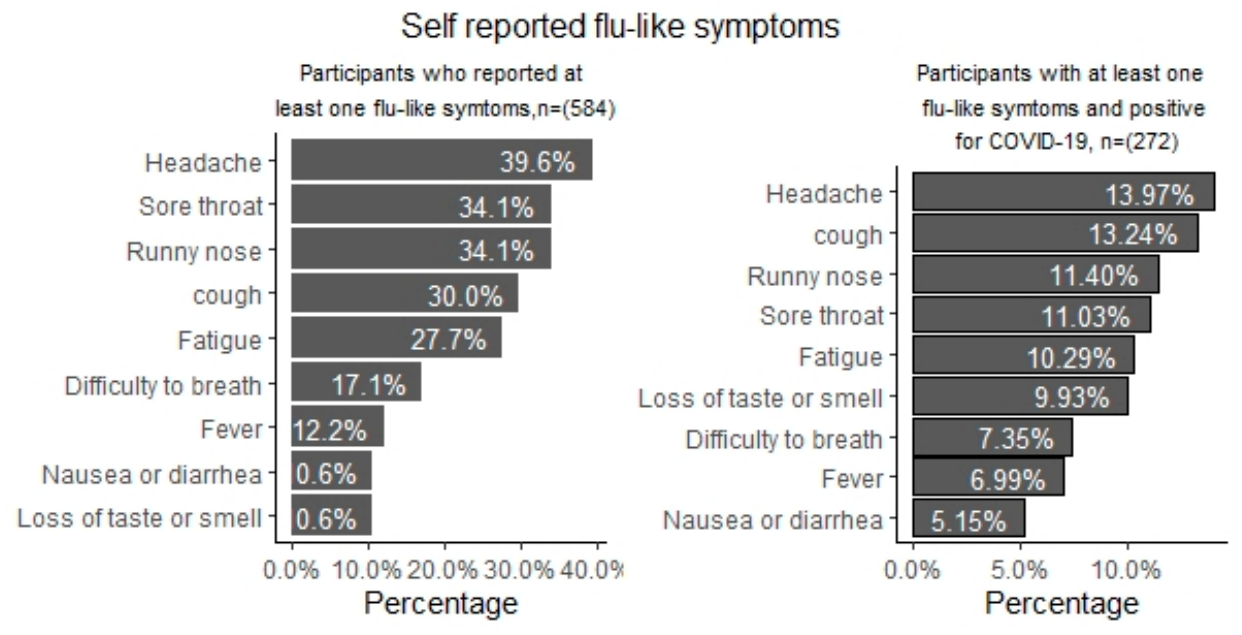
Figure 1. Self-reported flu-like symptoms among participants in Ecuador.